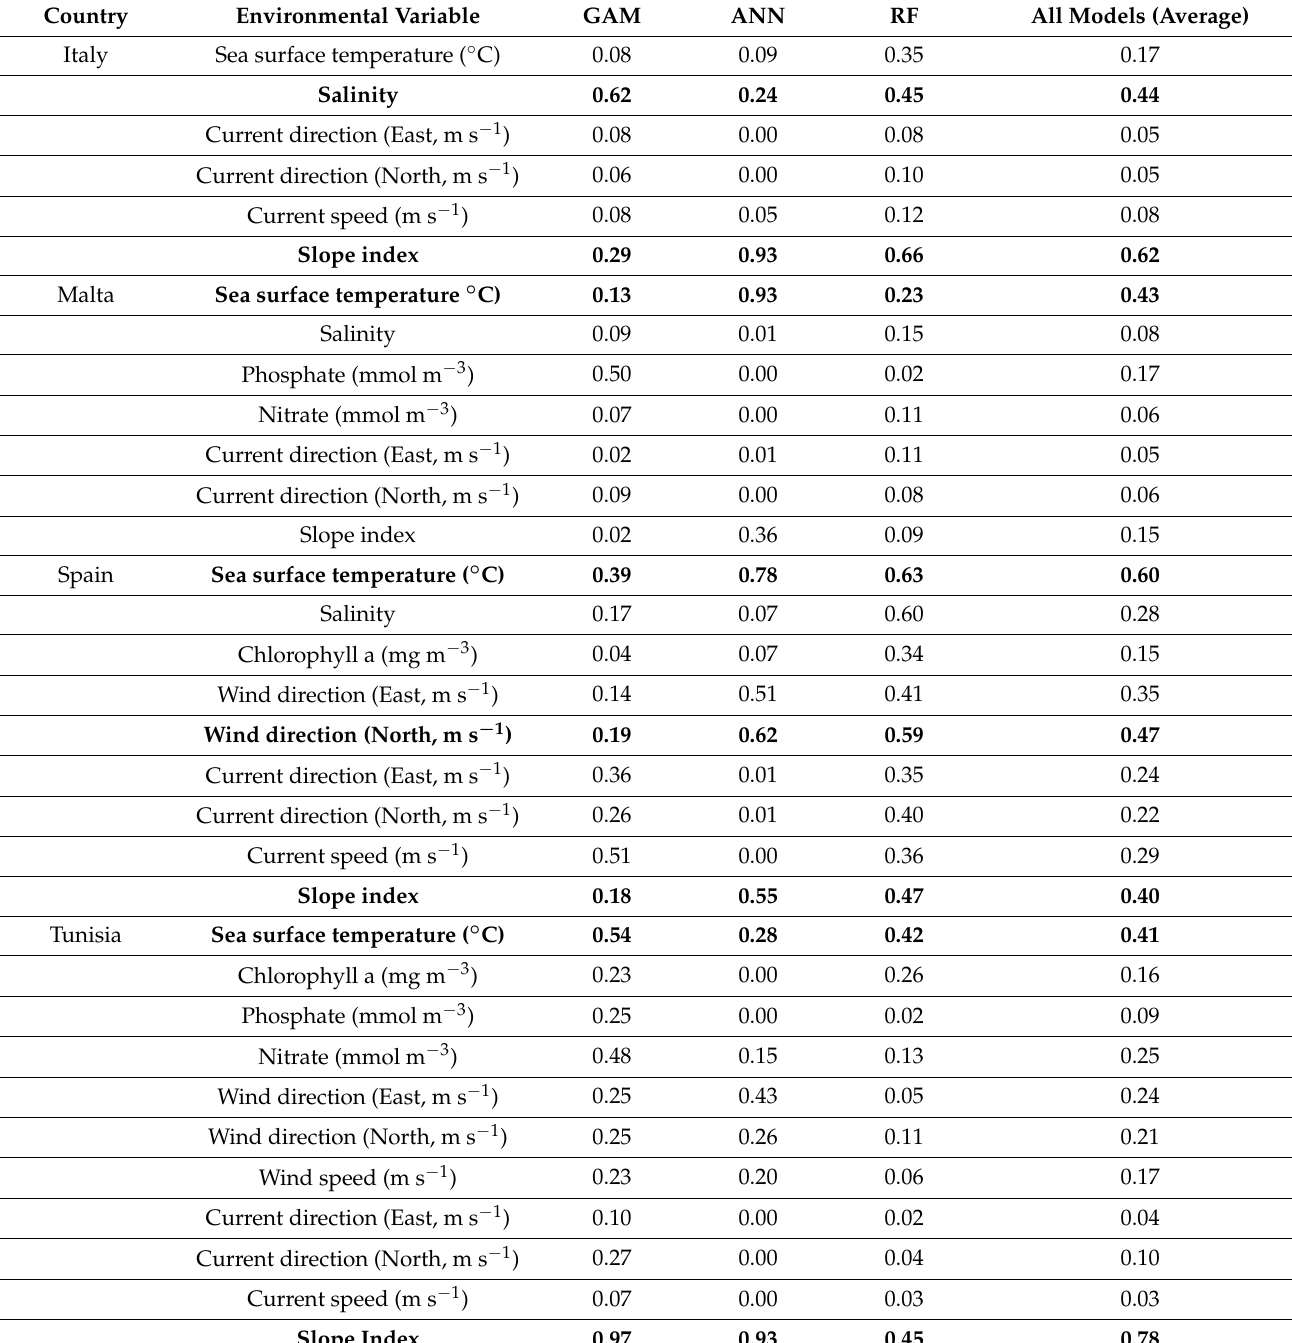
Table 2. Variable importance estimates for each explanatory variable for Pelagia noctiluca distribution models. GAM: generalized additive model, ANN: artificial neural network, RF: random forest. Those variables with an importance estimate > 0.4 are highlighted in